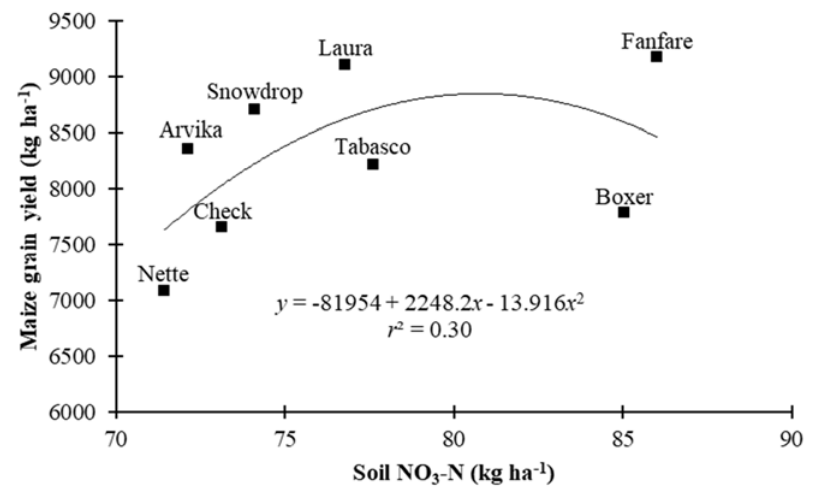
Figure 2. Interaction between spring soil NO 3 –N and maize grain yield in 2018, following fall cover crops.